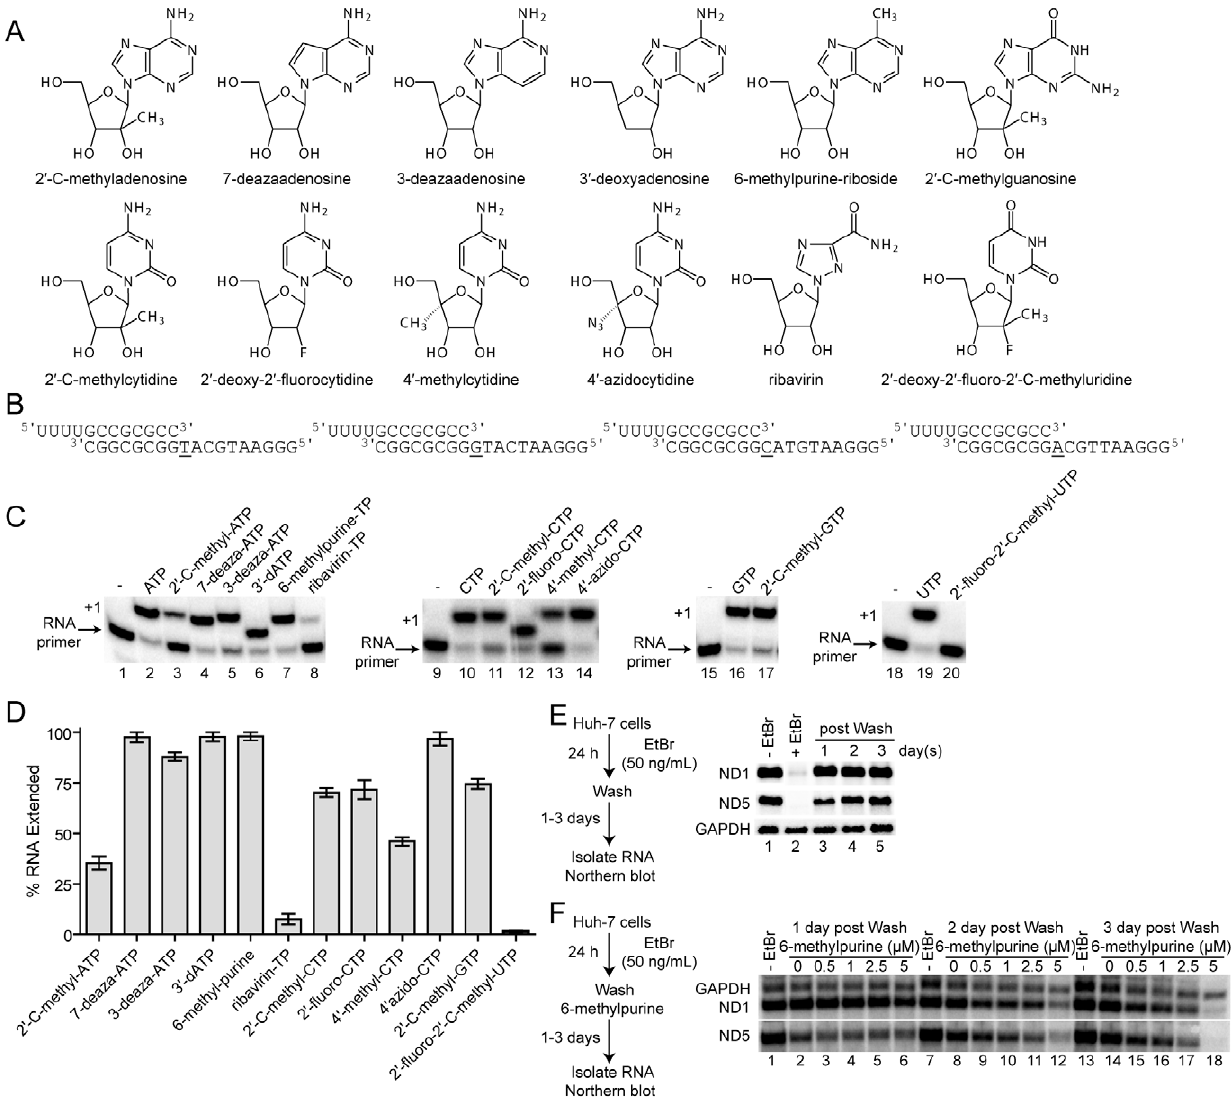
Figure 1. Antiviral ribonucleoside triphosphates are substrates for POLRMT. ( A ) Nucleoside analogs used in this study. ( B ) RNA-primed DNA templates. The first templating base is underlined. ( C ) Nucleoside analog incorporation catalyzed by POLRMT. Reaction products from POLRMT- catalyzed nucleotide incorporation using the indicated nucleoside analog triphosphate and RNA primer/DNA template nucleic acid scaffolds shown in panel b. Reactions proceeded for 30 s. RNA primer was extended to n + 1 in the presence of each nucleoside triphosphate. ( D ) Percentage of RNA product relative to correct nucleotide (ATP, CTP, GTP or UTP) is shown. Error bars represent s.e.m. n=3. Both 2 9 -deoxy-2 9 -fluoro-2 9 -C-methyl-UTP and ribavirin triphosphate were the least incorporated nucleoside analogs. ( E ) Inhibition of mitochondrial transcription by ethidium bromide (EtBr) and the recovery of mitochondrial transcription. Northern blots of mitochondrial transcripts ND1, ND5 and nuclear transcript GAPDH 24 h post EtBr treatment and 1, 2 and 3 day(s) post wash. Mitochondrial transcripts ND1 and ND5 were inhibited by EtBr treatment and recovered post wash; there was no effect on GAPDH. ( F ) Effect of 6-methlypurine on POLRMT-catalyzed transcription in vivo. Northern blots of ND1, ND5 and GAPDH after EtBr treatment and recovery in the presence of